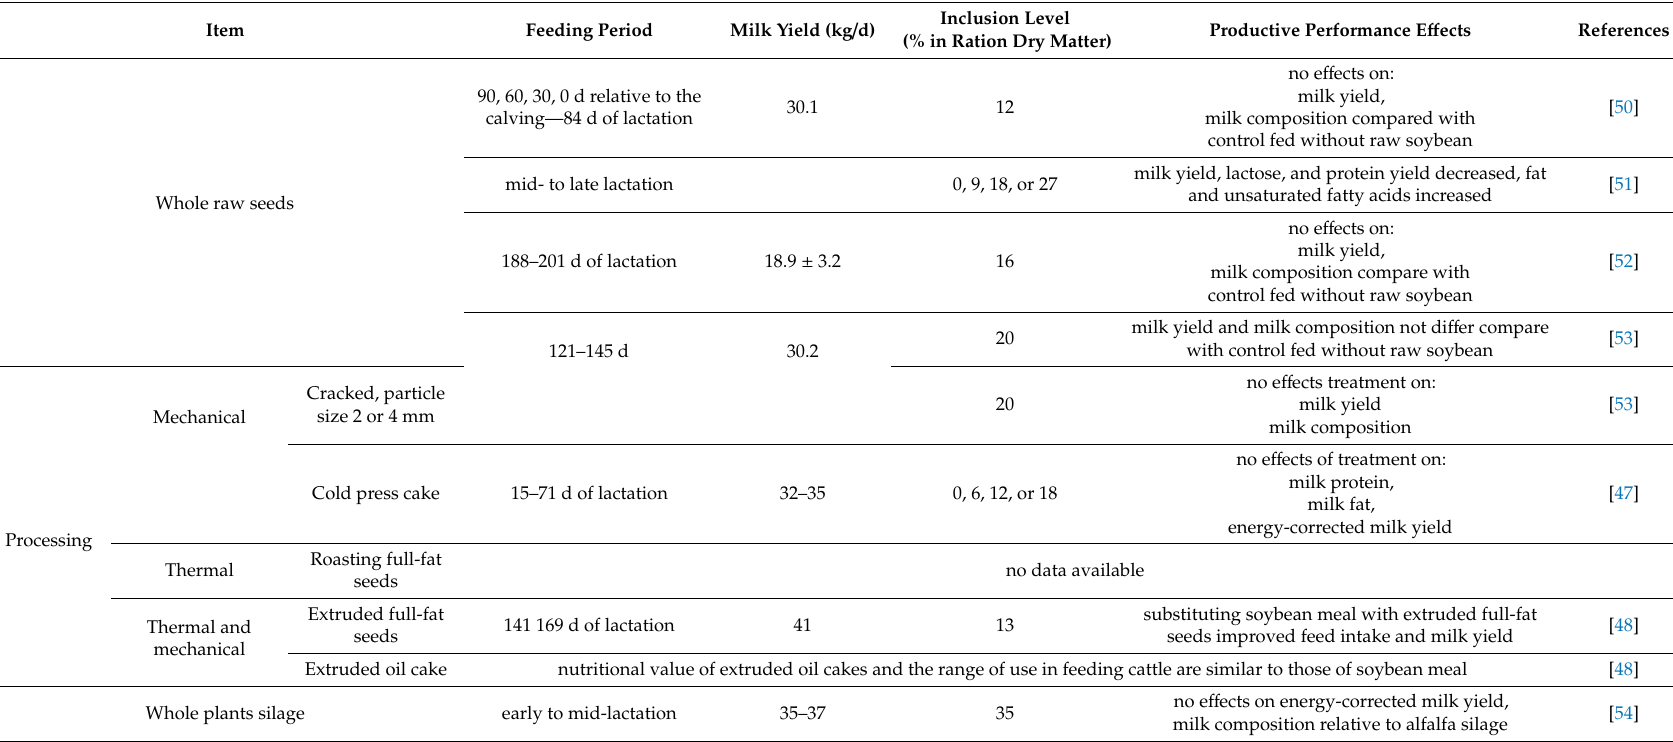
Table 3. E ff ects of raw soybean seeds, their processing products, and soybean forage inclusion in ration on performance in dairy